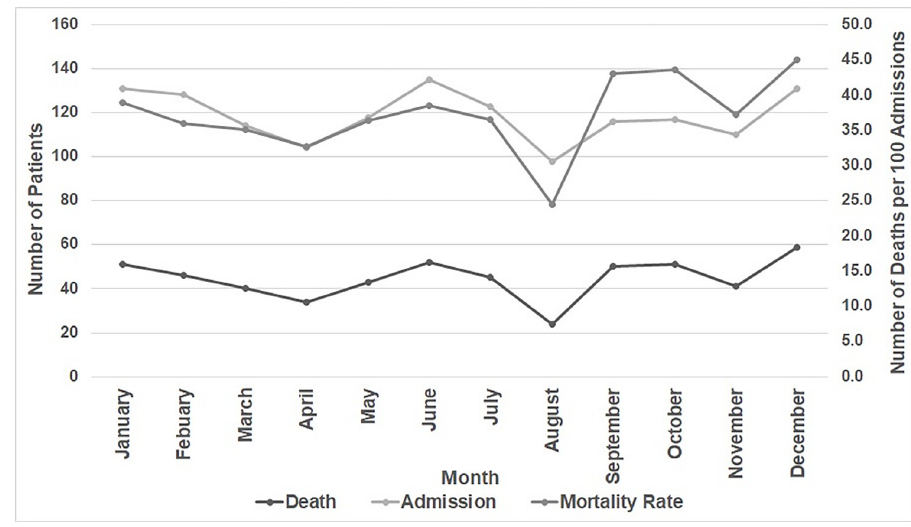
Fig 1. Monthly analysis of admission versus death over three years in the